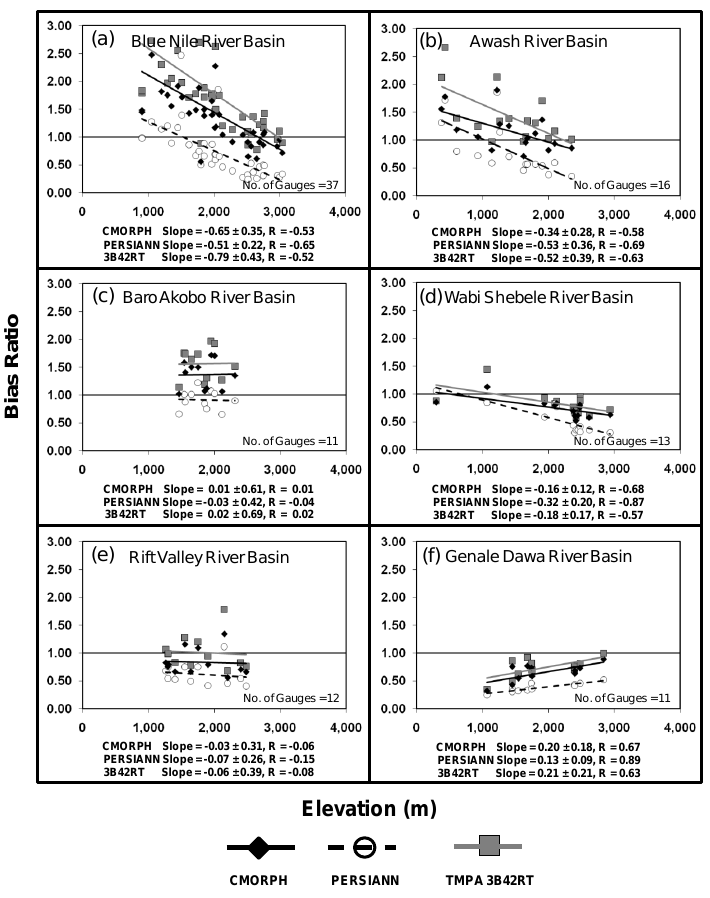
Fig. 6. Bias Ratio vs. Elevation for the Minor Rainy Season Figure 6 – Bias Ratio vs. Elevation for the Minor Rainy Season (Belg)